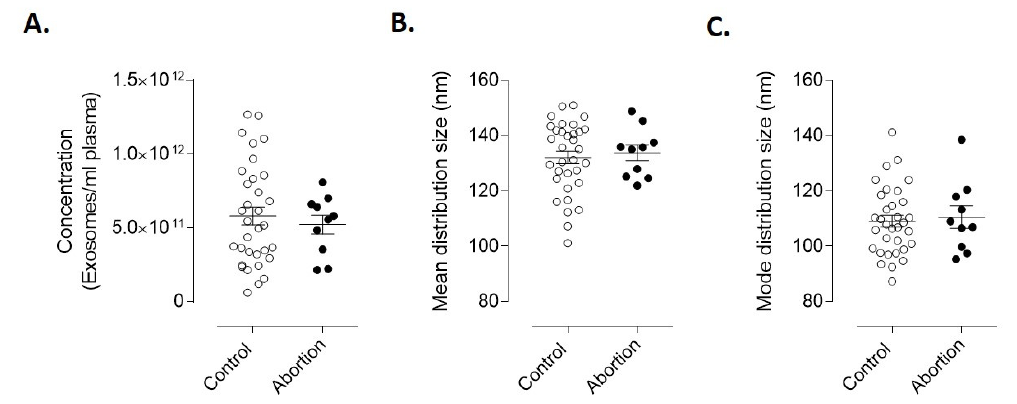
Figure 1. Characterization of extracellular vesicles (EVs) isolated from plasma using ExoQuick TM in controls and patients who had spontaneous abortion. ( A ) Mean particle diameter of EVs obtained from plasma for all the samples by nanoparticle tracking analysis. ( B ) Representative image of transmission electron microscopy of the EVs obtained. [ ], representes area zoomed in the upper right corner with 100nm; arrows indicate extracellular vesicles. ( C ) Protein extracted from EVs was isolated and analyzed by Western blot at different gestational ages to determine the protein expression levels of CD63, Alix, and Flotillin-1.